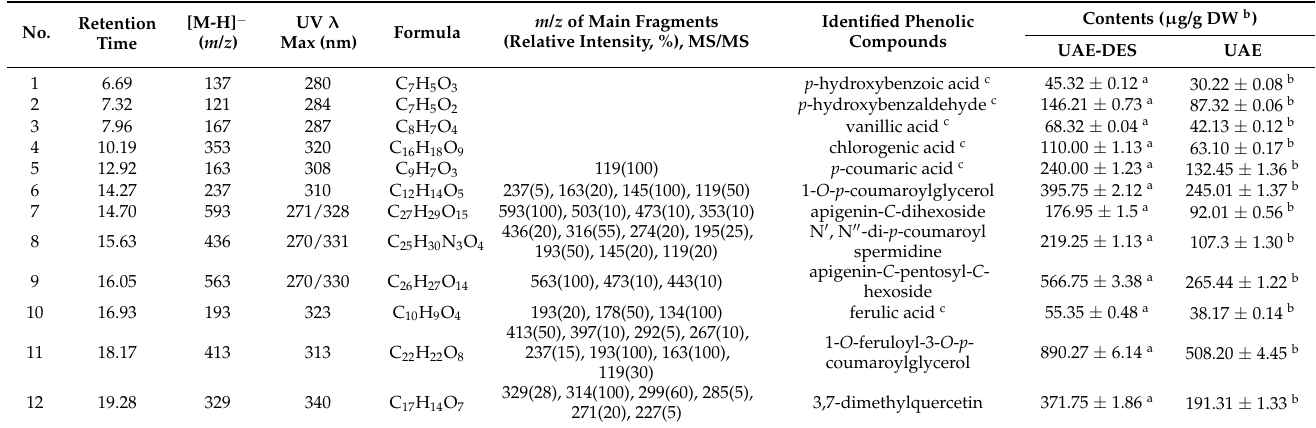
Figure 4. UPLC profile of polyphenol compounds of foxtail millet husk at 280 nm. The peaks of compounds were numbered by their elution times. Table 5. Identification and quantification a of phenolic compounds in foxtail millet